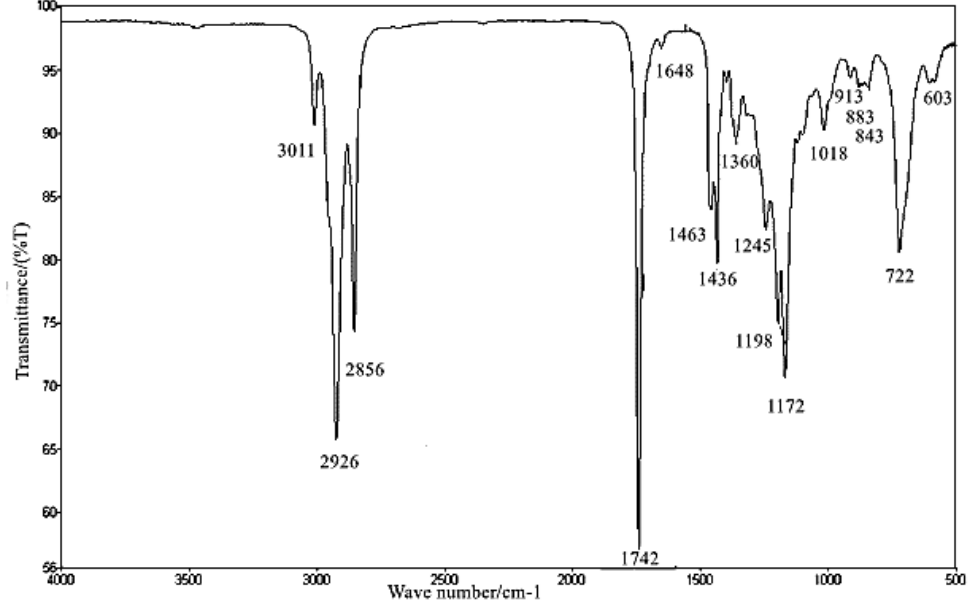
Figure 10. FT-IR spectroscopy result confirming SMB formation through peaks for important functional groups tional